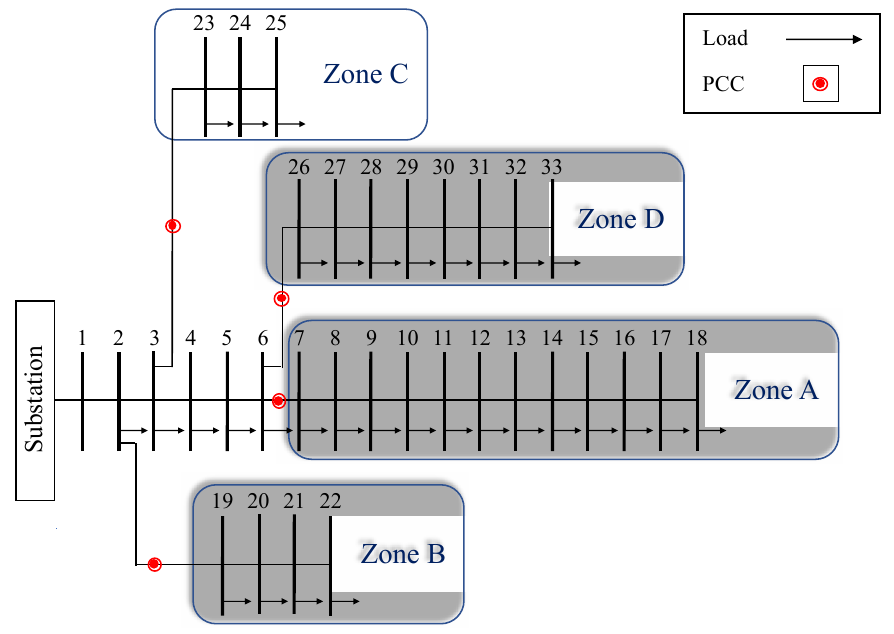
Figure 3. IEEE-33 bus distribution system, including largest possible centralized zones. Table 1. Zones Topology.